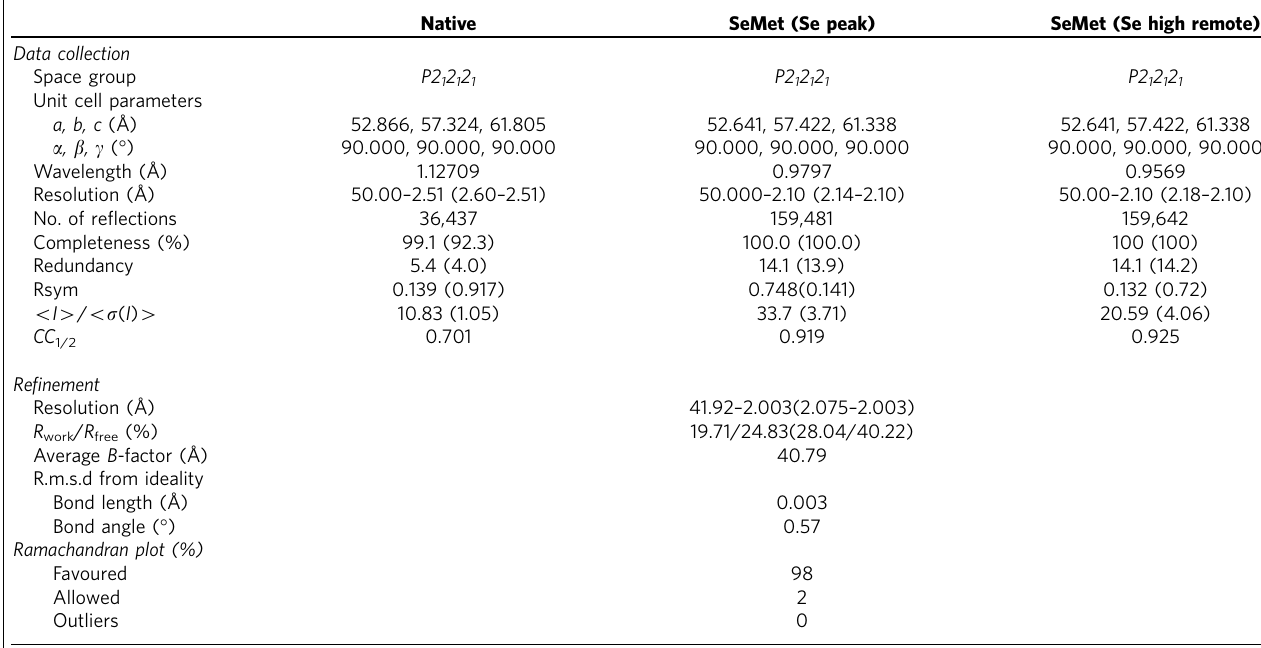
Table 1 | Statistics of crystallographic data reduction and